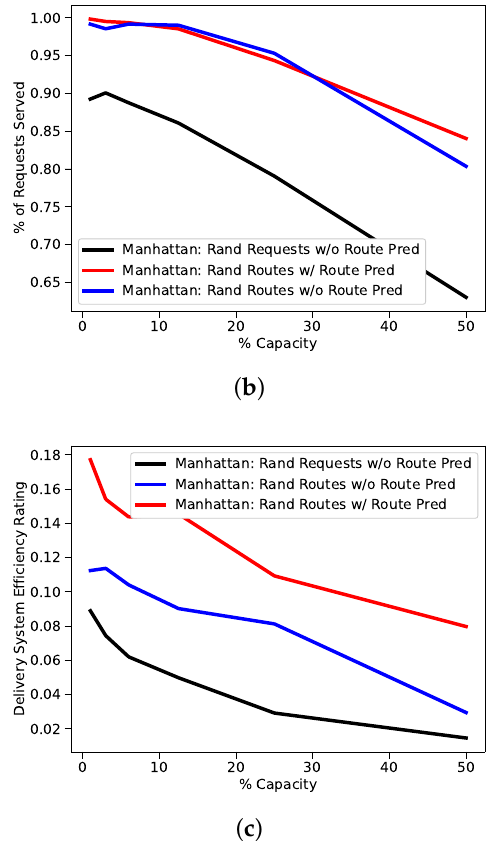
Figure 7. A comparison between three subsampled Manhattan studies. ( a ) The first study dis- abled route prediction, randomized pickup requests, and generated routes from taxi data. ( b ) The second study disabled route prediction, generated pickup requests from taxi data, and random- ized routes. ( c ) The third study enabled route prediction, generated requests from taxi data, and randomized